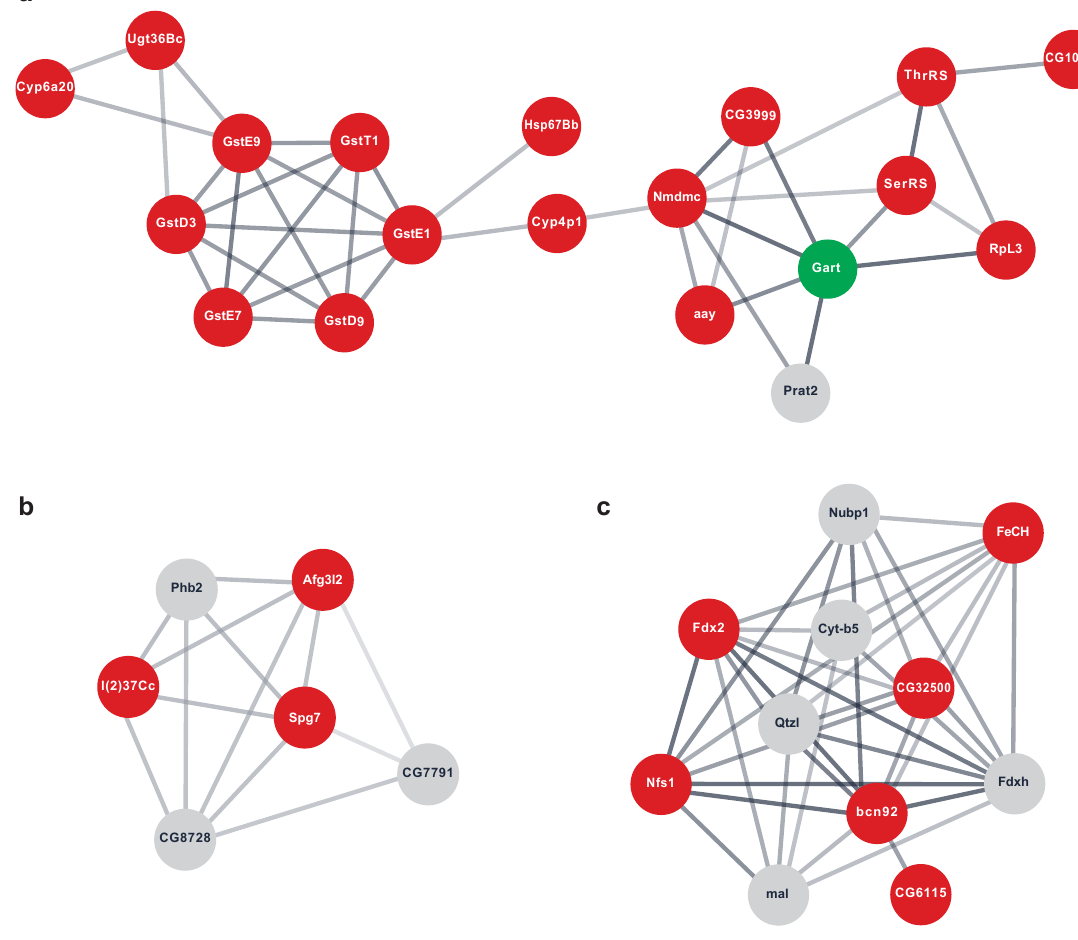
Figure 8. String network analysis of dPerk-dependent targets differentially regulated by the transcriptome and proteome. Genes upregulated at the transcript level but not at the protein level were analysed (group 2, red). Clusters were determined using the inbuilt Cytoscape stringApp Markov Cluster (MCL) algorithm. Clusters were enriched with first neighbours from the background transcriptomic network in order to find additional functionally related targets not recognised by the TMT labelling. The nodes representing molecules with an upregulation in transcript levels but no available protein value (grey) and molecules with an upregulation in transcripts and downregulation in protein levels (green) were added. Molecular pathways involved in glutathione and nucleotide metabolism ( a ), processing of essential mitochondrial calcium uniporter regulator (EMRE) ( b ) and iron-sulphur metabolism ( c ) are